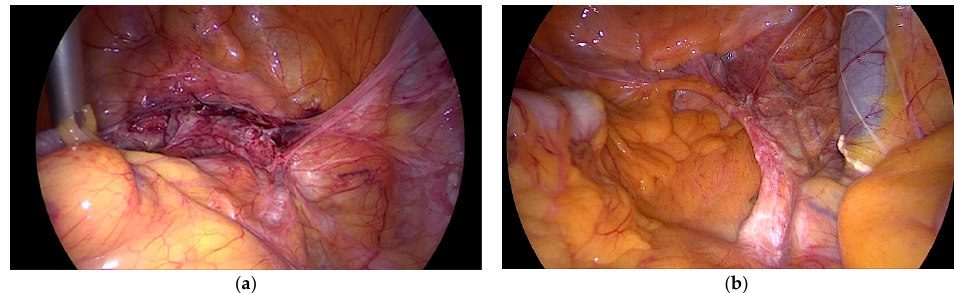
Figure 2. ( a ) Laparoscopic sacral colpopexy (LSC) 10 years after surgery and ( b ) 12 years after surgery, both fixed to the longitudinal ligament on SV2 (Sacral Vertebra 2).